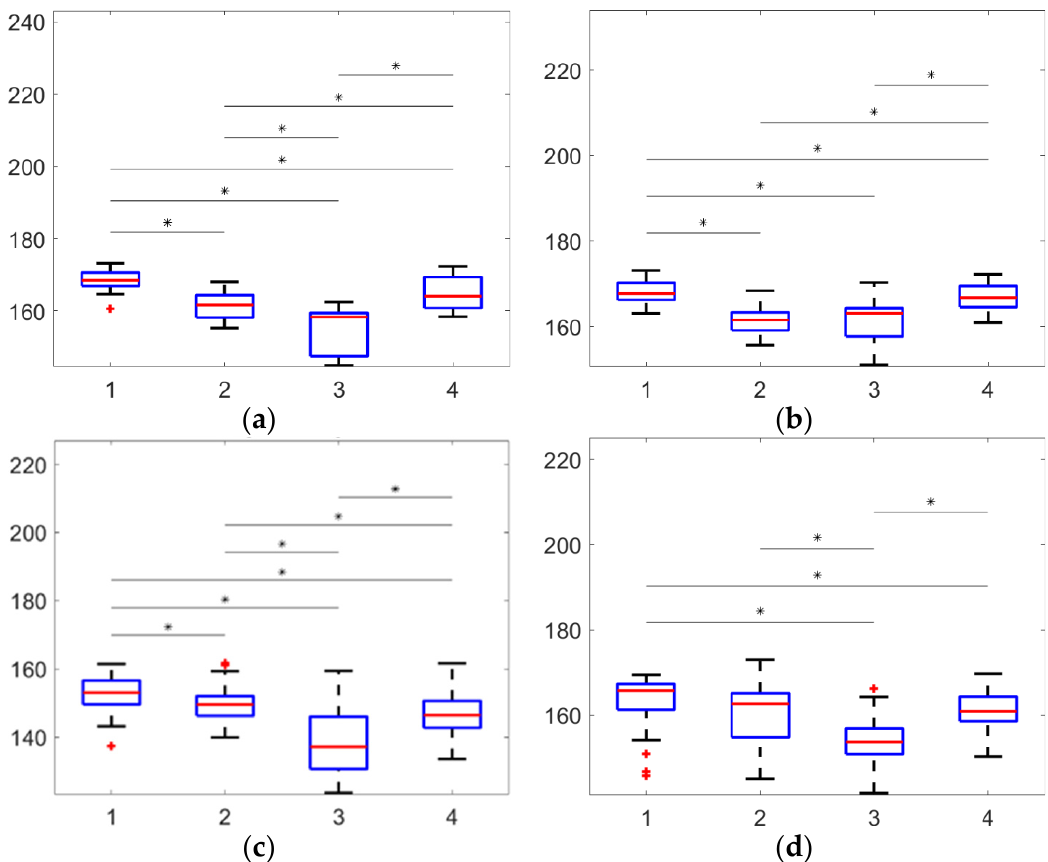
Figure 6. Data distribution in clusters: ( a ) hip angle value (°) in the swing phase, ( b ) hip angle value